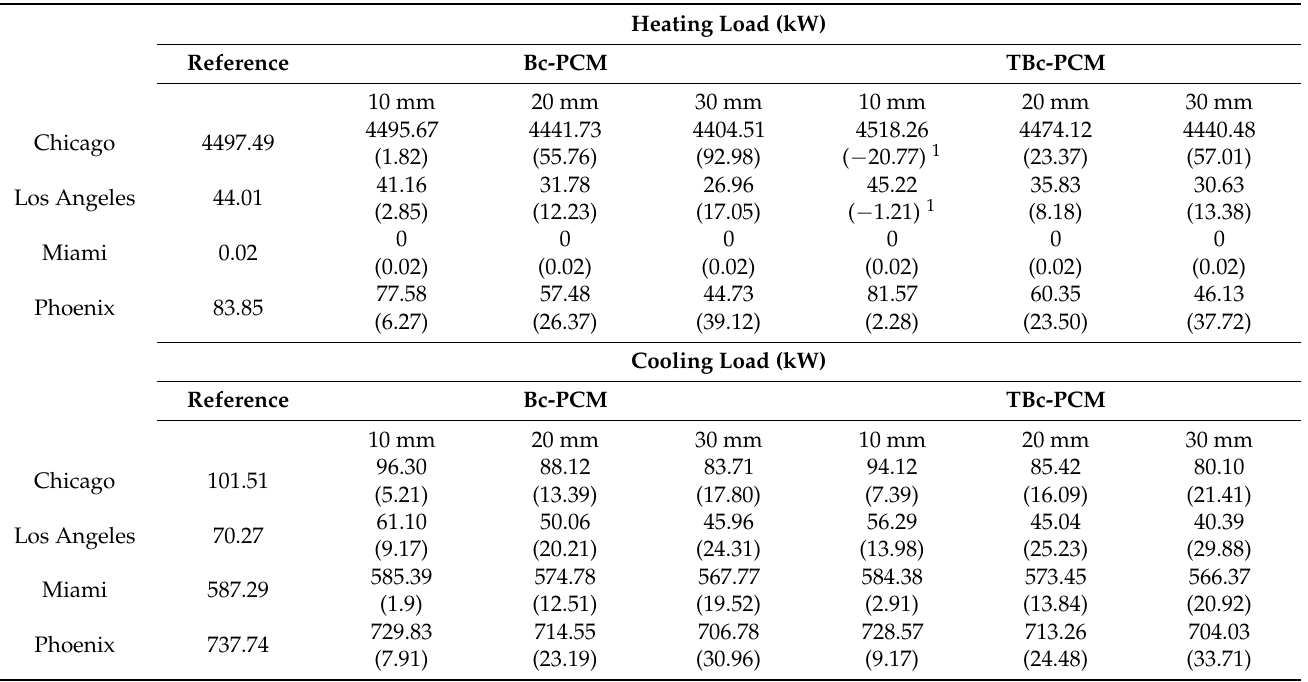
Table 4. Annual energy consumptions and reduction rates of building